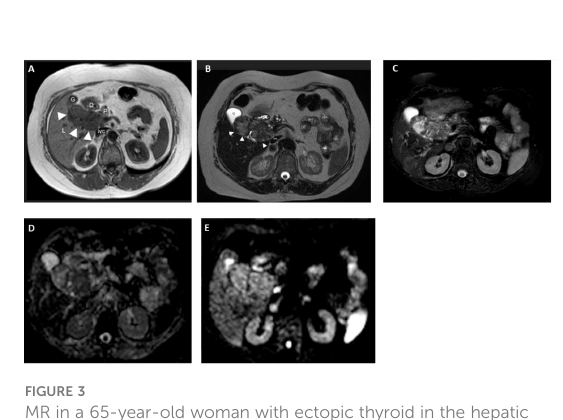
FIGURE 3 MR in a 65-year-old woman with ectopic thyroid in the hepatic hilum. (A) Axial T1 image. Dishomogeneously hypointense (with respect to the liver) mass in the right hypochondrium between the duodenum (D), liver (L), pancreas (P), gallbladder (G), and inferior vena cava (ivc). Axial (B) T2 and (C) T2 fat-sat images. The mass is dishomogenously hyperintense with respect to the liver. (D) DWI B800 image. The mass shows no meaningful restriction. (E) ADC image. High ADC in the mass. (F) MR- Cholangiography. Common bile duct (cbd) compressed and dislocated by the bilobated mass (m); C, choledocus; G, gallbladder; M (mass); Wirsung (arrowheads).